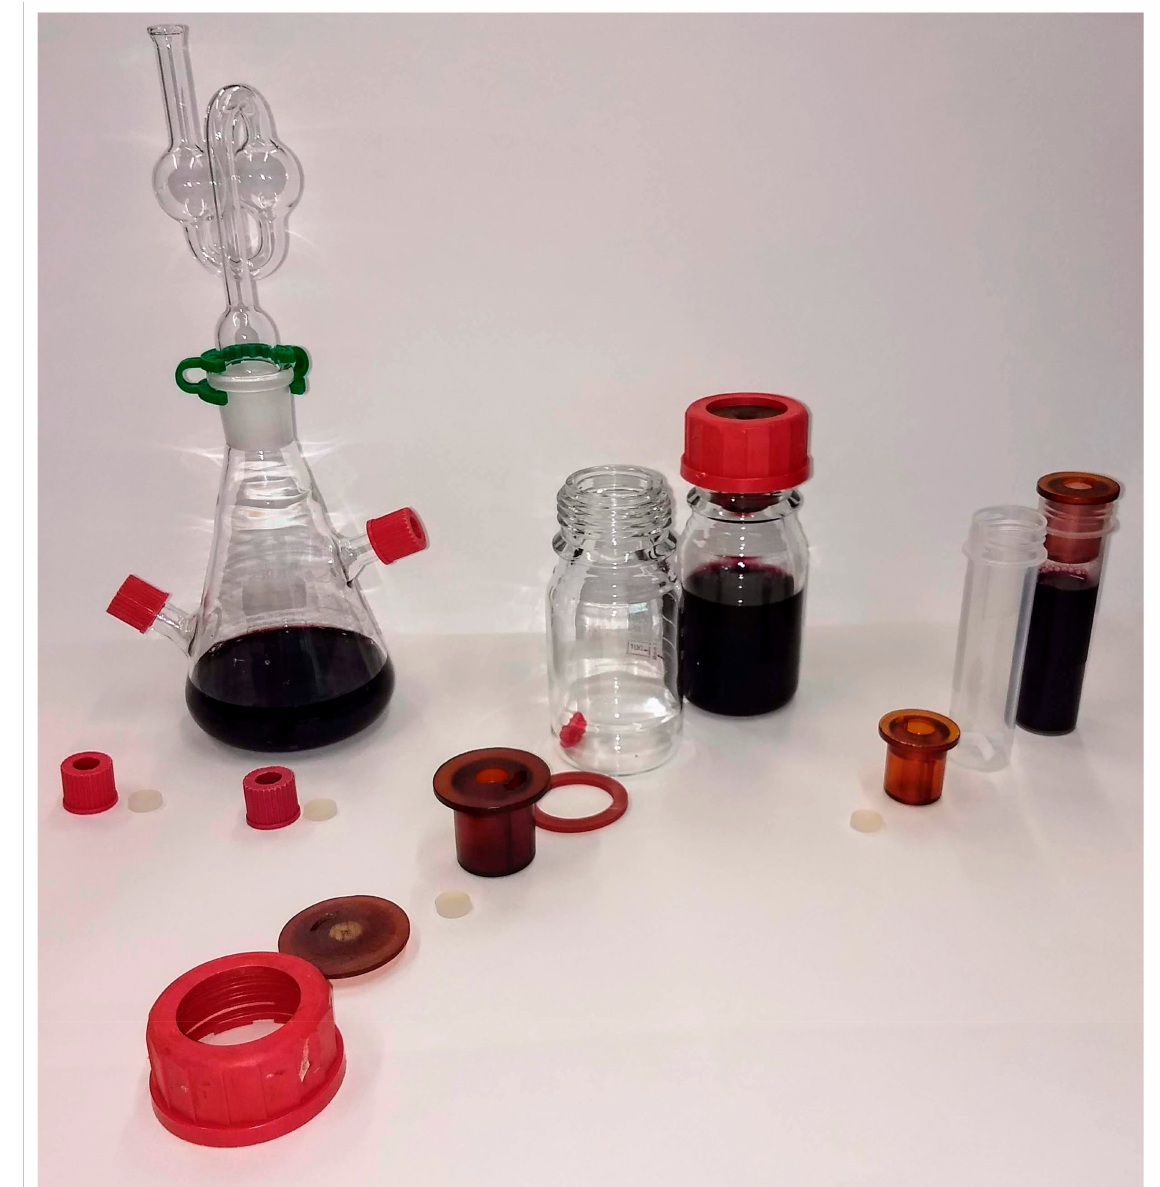
Figure 3. Comparison of fermentation